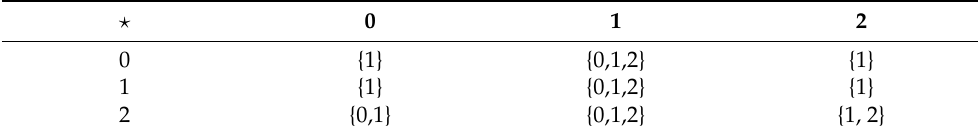
Table 17. The binary hypergroupoid ( C , (cid:63) ). (cid:63) 0 1 2 0 {1} {0,1,2} {1} 1 {1} {0,1,2} {1} 2 {0,1} {0,1,2} {1,